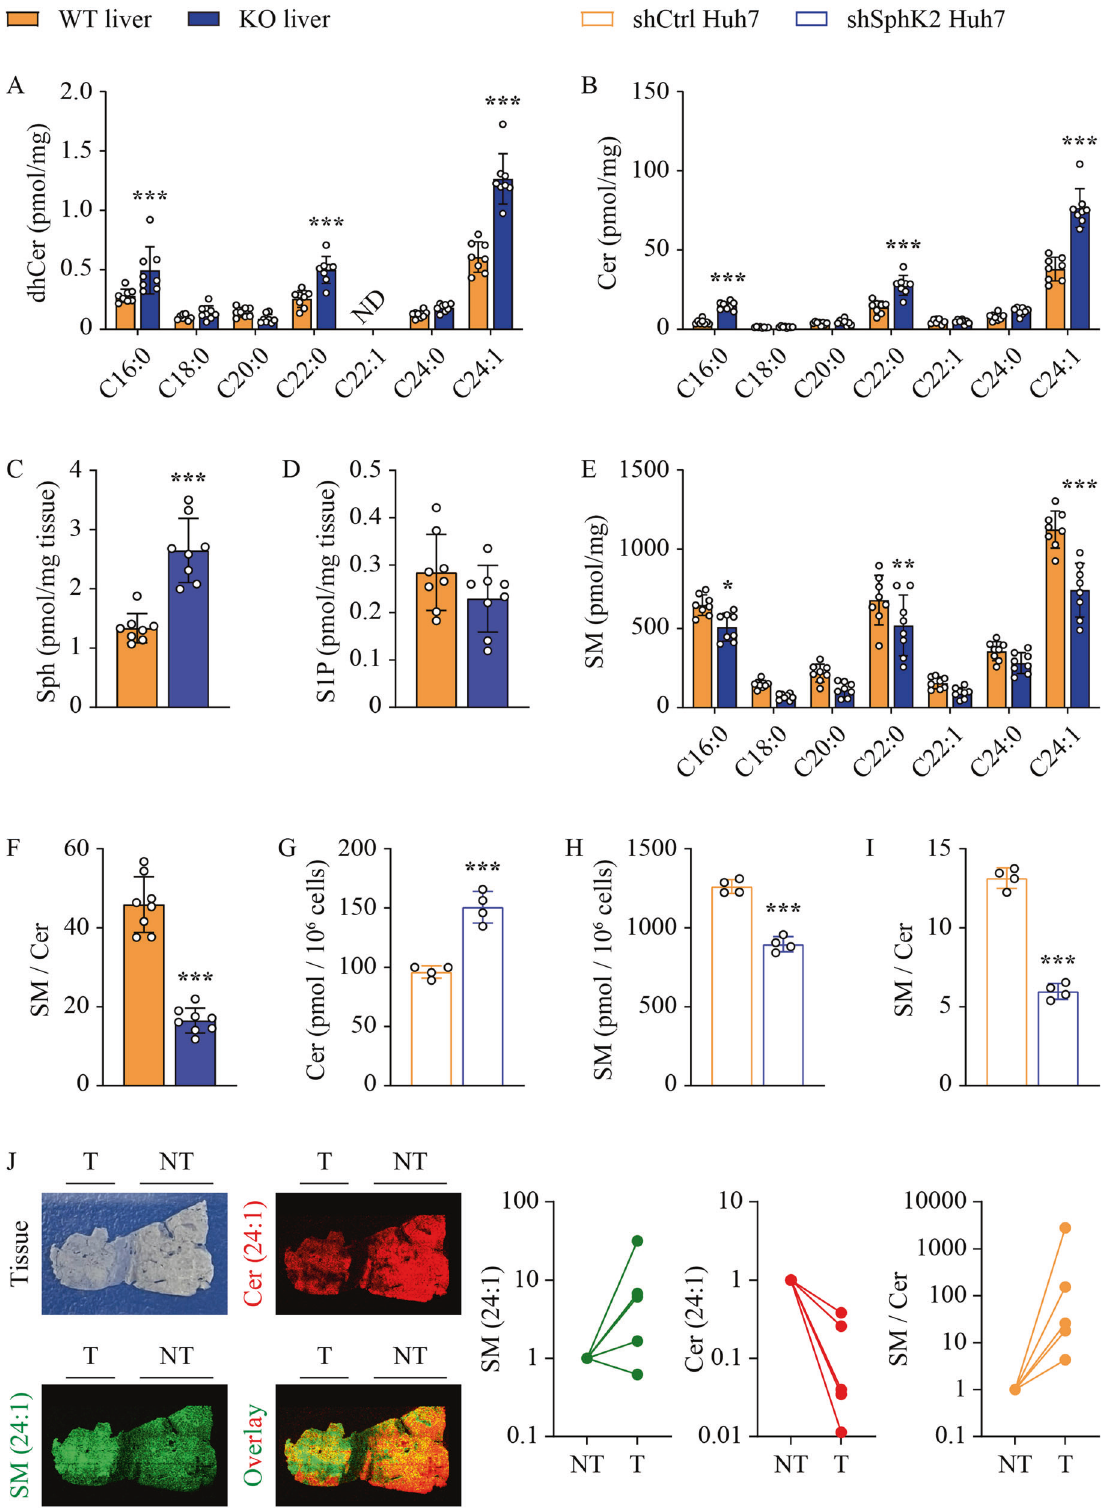
Fig. 4 The altered sphingolipid pro fi le in Sphk2 -KO livers. A – F Wild-type (WT) and Sphk2 knockout (KO) mice were fed with a high-fat, high- sugar diet (HFHSD) for 46 weeks. G – I Huh7 hepatic cells were transduced with lentiviral-based short hairpin RNA (shRNA) to knock down SphK2 and then treated with a combination of free fatty acids (FFA, 200 µM palmitate + 400 µM oleate) for 48 h. Lipids were extracted in non- tumorous liver tissues and FFA-treated cells and analyzed using lipidomics. (A) dihydro-ceramide (dhCer), B , G ceramide (Cer), C sphingosine (Sph), D sphingosine 1-phosphate (S1P), and E , H sphingomyelin (SM) were determined. F , I the ratio of SM to ceramide. J Levels of C24:1 SM and C24:1 Cer in human HCC (T) and adjacent non-tumorous (NT) tissues were visualized and using DESI mass spectrometry imaging coupled with ion mobility and quanti fi ed by HDI software. Data are expressed as mean ± SD. n = 8 A – F ; n = 4 G – I ; n = 5 J . * p < 0.05; ** p < 0.01; *** p < 0.001, versus